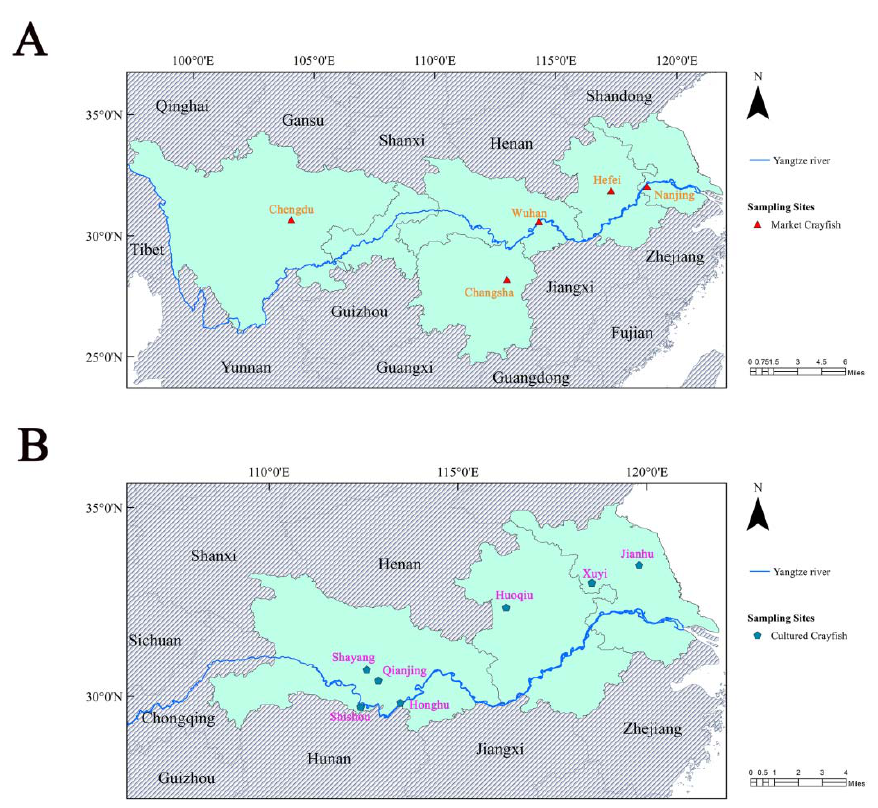
Figure 1. Maps of sampling sites indicating study areas. (( A ): Sampling sites of market crayfish; ( B ): Sampling sites of cultured crayfish) .